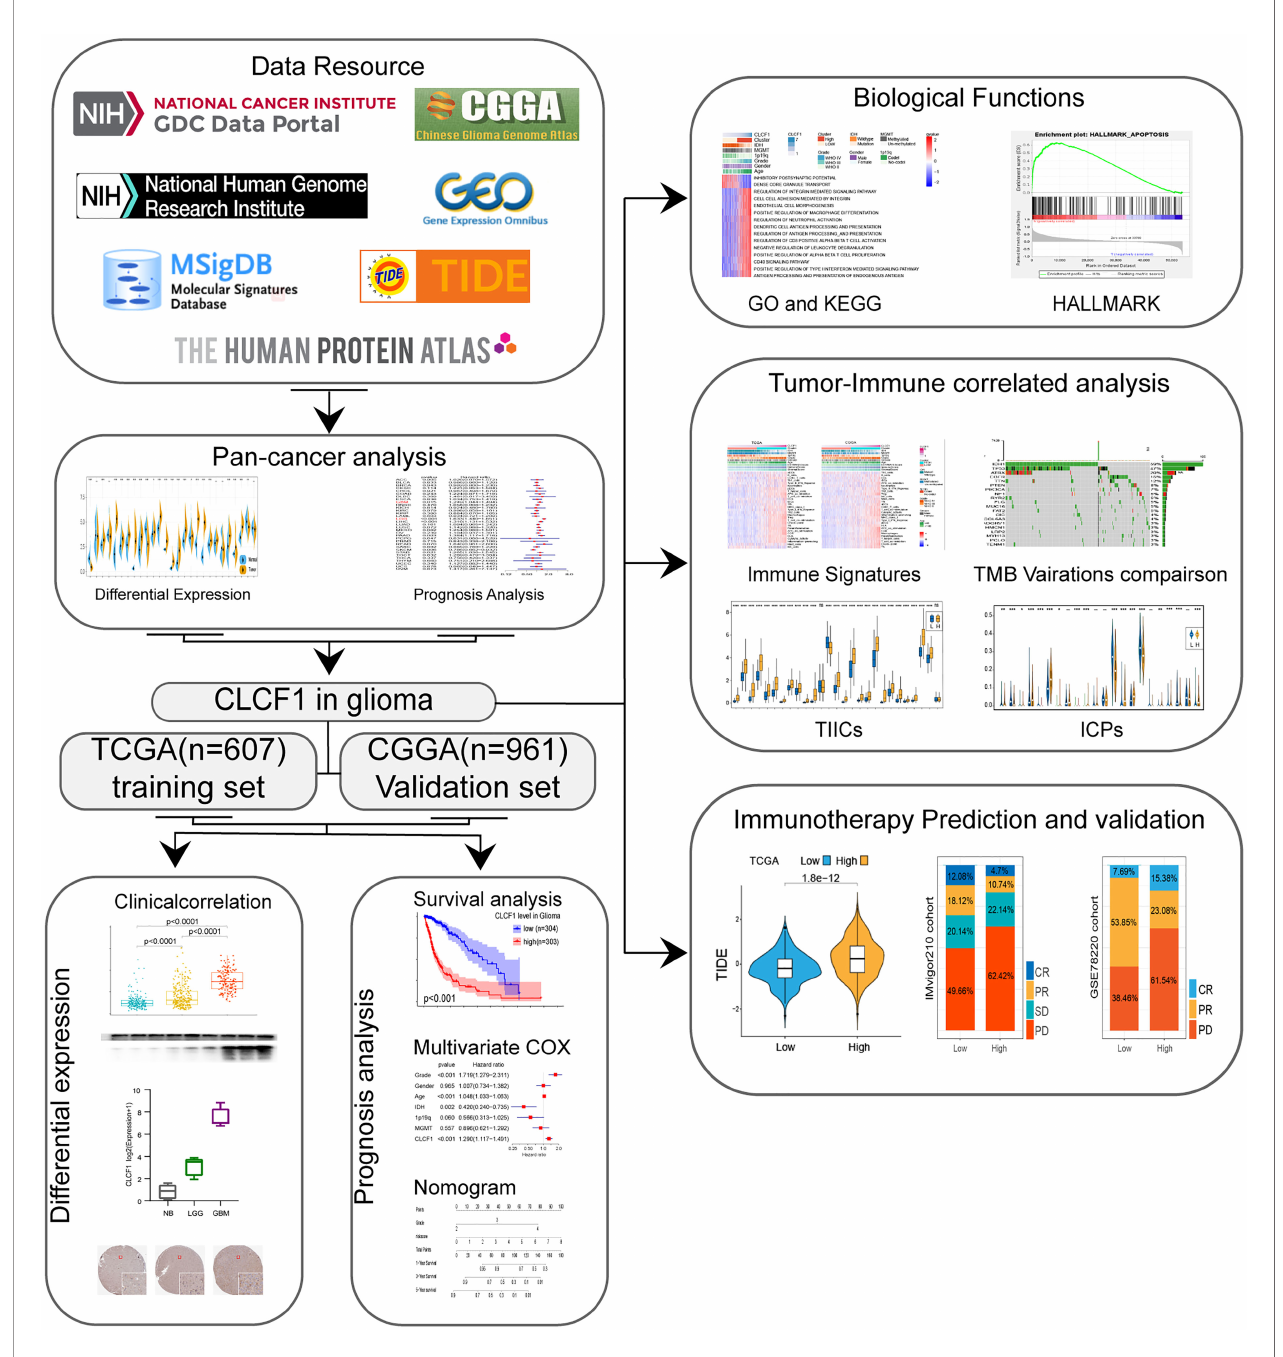
FIGURE 1 | Study fl ow